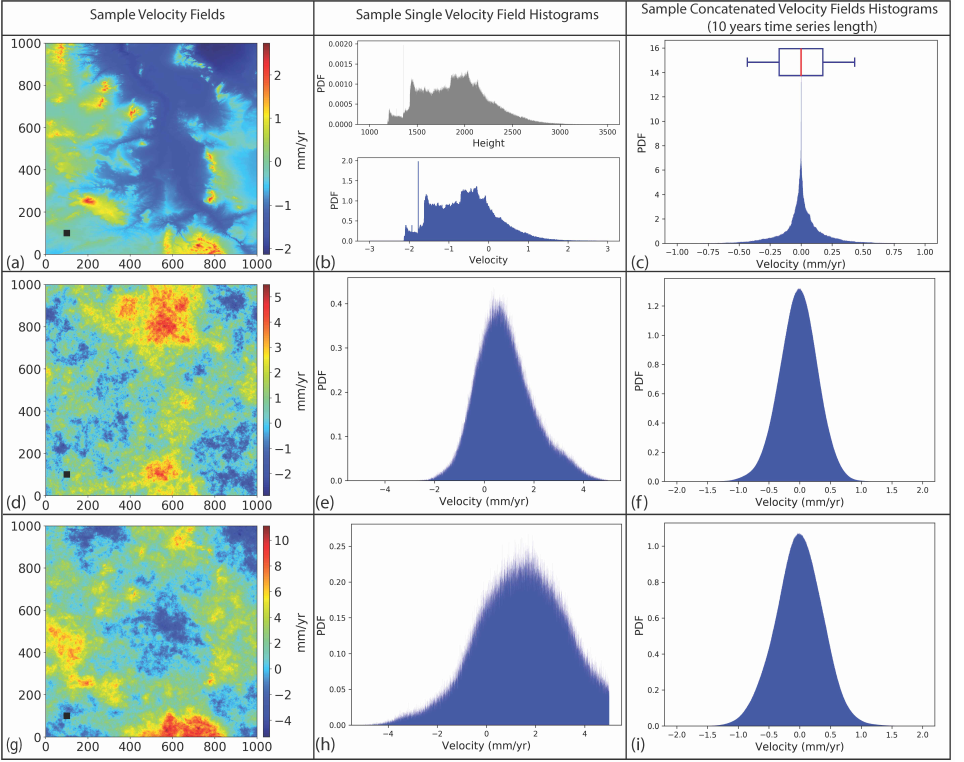
Figure 5. Velocity maps of tropospheric delays due to ( a ) vertical stratification, ( d ) turbulence mixing, and ( g ) their combination tropospheric delays: each velocity map was calculated from 32 simulated scenes with a 35-day acquisition interval reflecting a 3-year-long time series. ( b ) A histogram representing the velocity distribution in ( a ) compared with elevation distribution. ( c ) The velocity distribution obtained by joining 100 tests of random vertical stratification. The box plot represents a 95% confidence interval. ( e , h ) Histograms representing the velocity distribution in ( d , g ), respectively. ( f , i ) Histograms obtained by joining 100 tests of turbulence mixing ( d ) and a combination of vertical stratification and turbulence mixing ( g